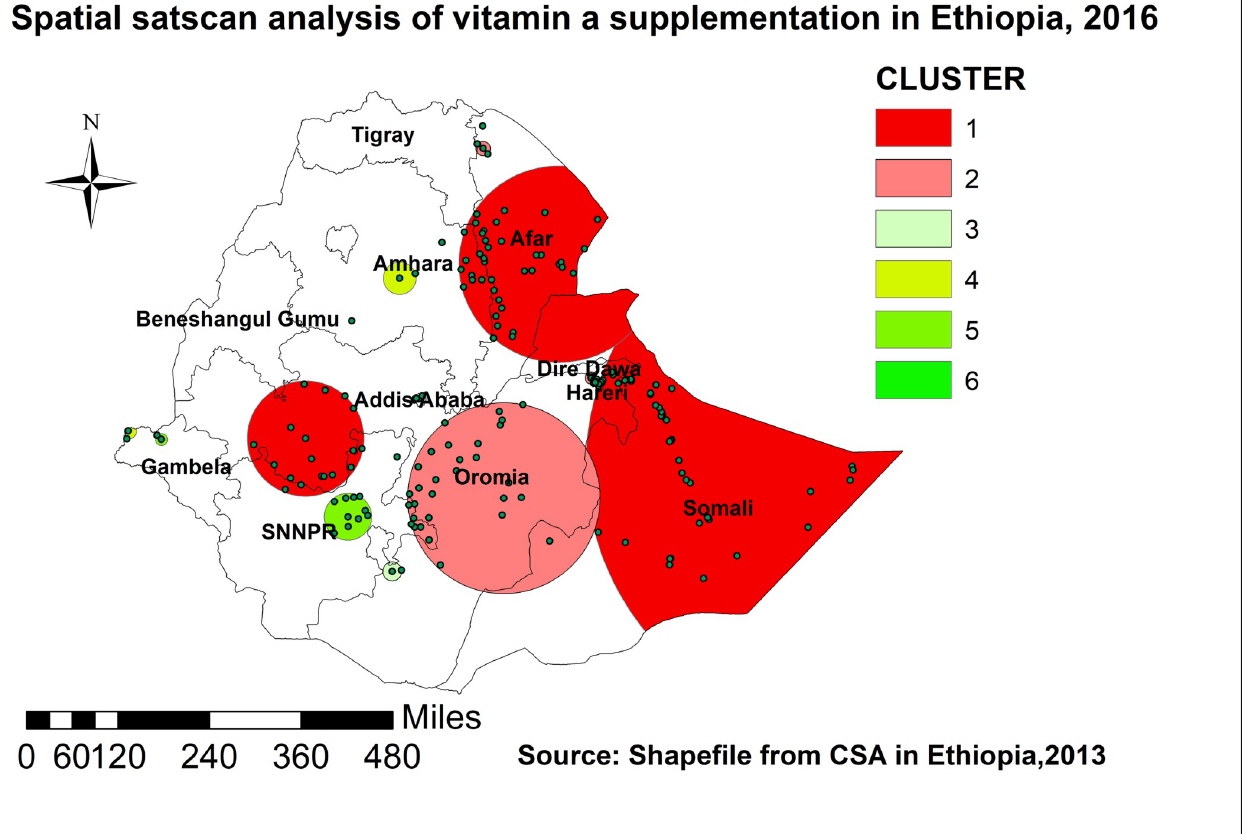
Fig 4. SaTScan scan statistics of vitamin A supplementation among children aged 6–59 months in Ethiopia, EDHS 2016.